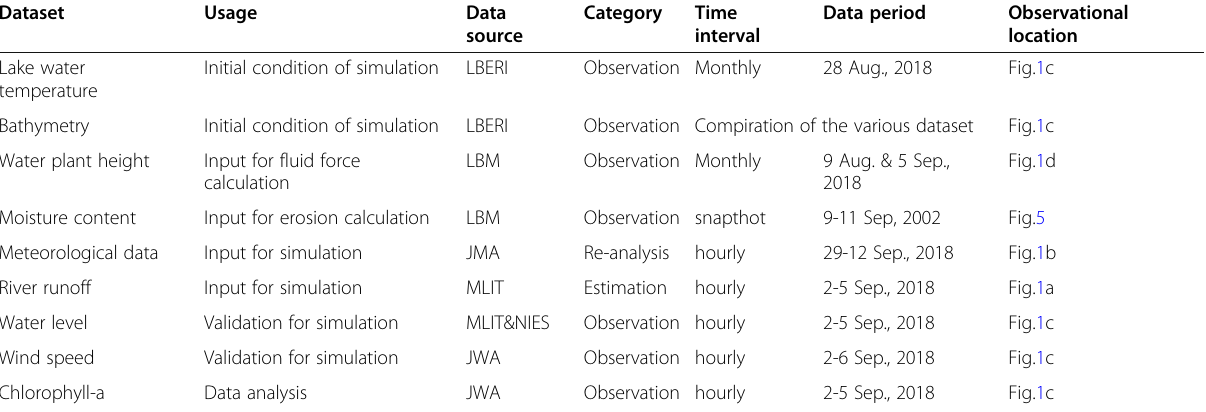
Table 1 The list of specifications for the datasets used in the simulation and analysis